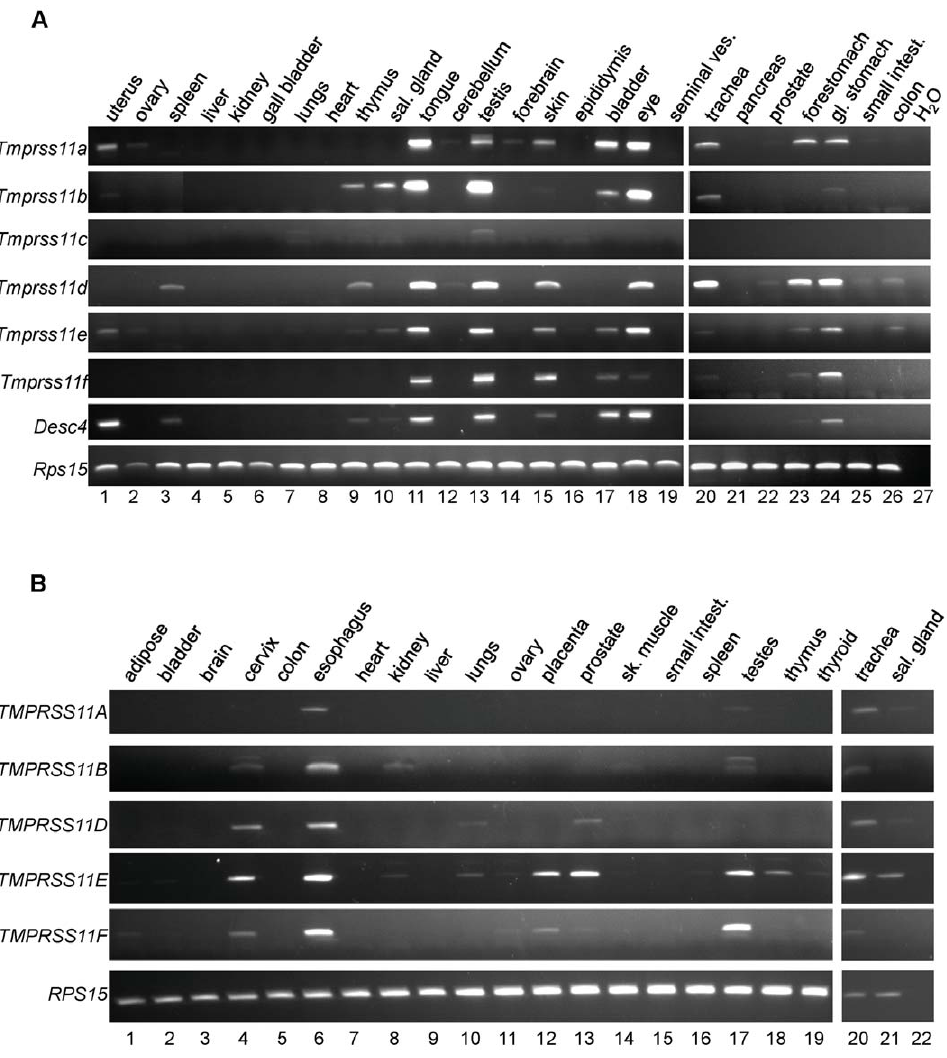
Figure 1. Distribution of HAT/DESC subfamily gene transcripts in mouse and human organs. PCR analysis of expression of mouse Tmprss11a-f and Desc4 , and expression of human TMPRSS11A , B and D – F using total RNA reverse transcribed from either 26 mouse organs of young adult mice (A) or from 21 human organs (B), as indicated. Mouse ( Rps15 ) and human (RPS15) ribosomal S15 protein genes were used as controls. All amplicons displayed their predicted molecular